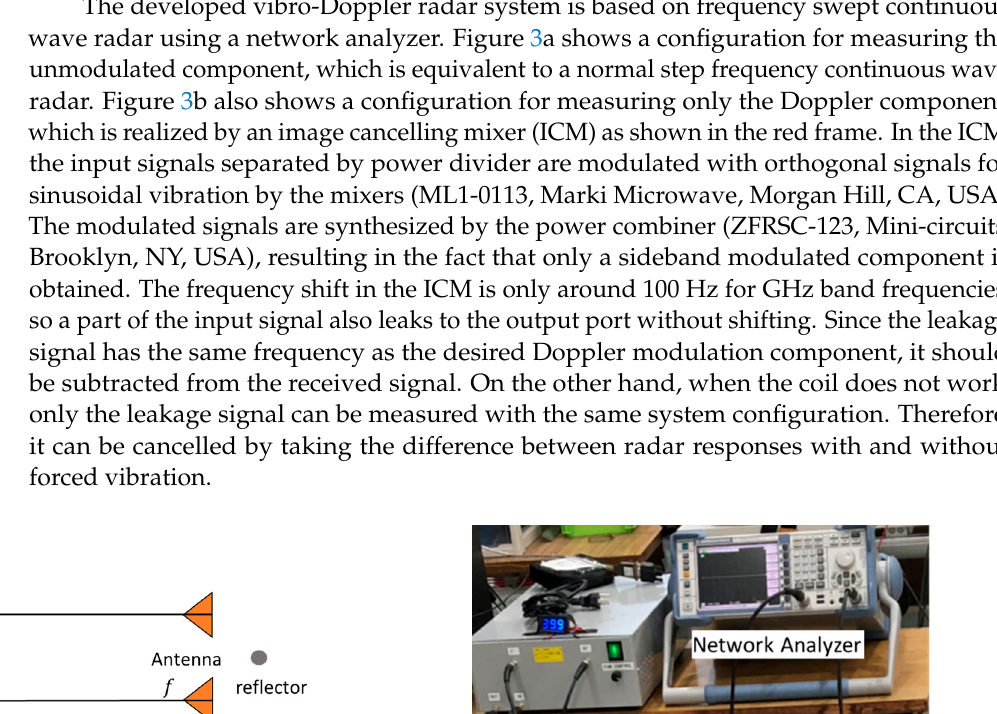
Figure 2. Geometry of problem.